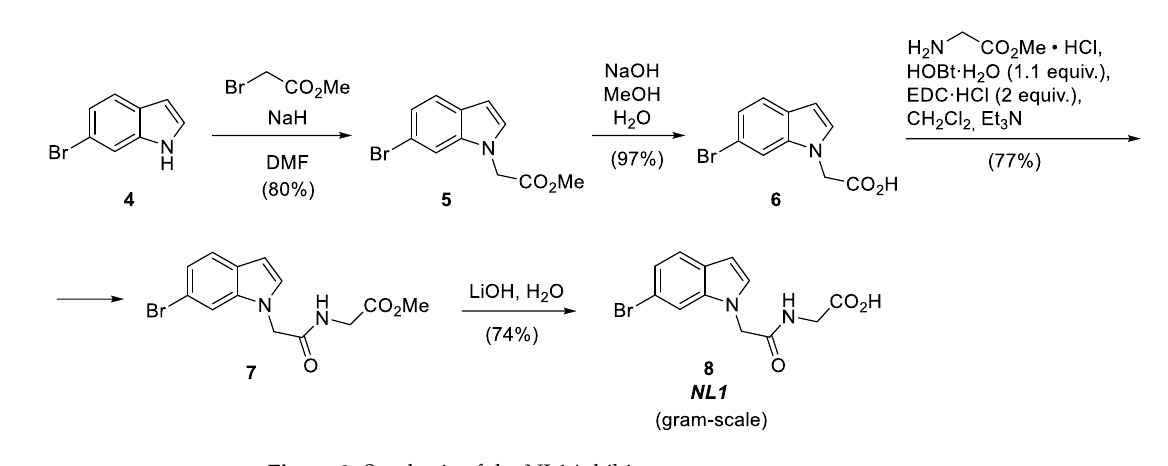
Figure 3. Synthesis of the NL1 inhibitor.